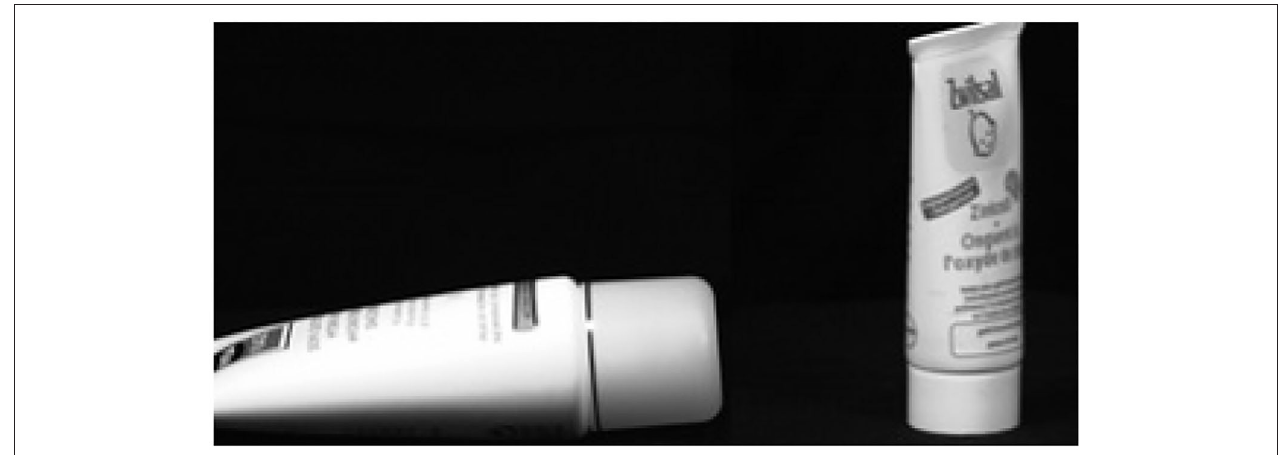
FIGURE 5 | Different tube positions allowing the use of different grasps, such as pronated palmar, tripod, pinch, and neutral